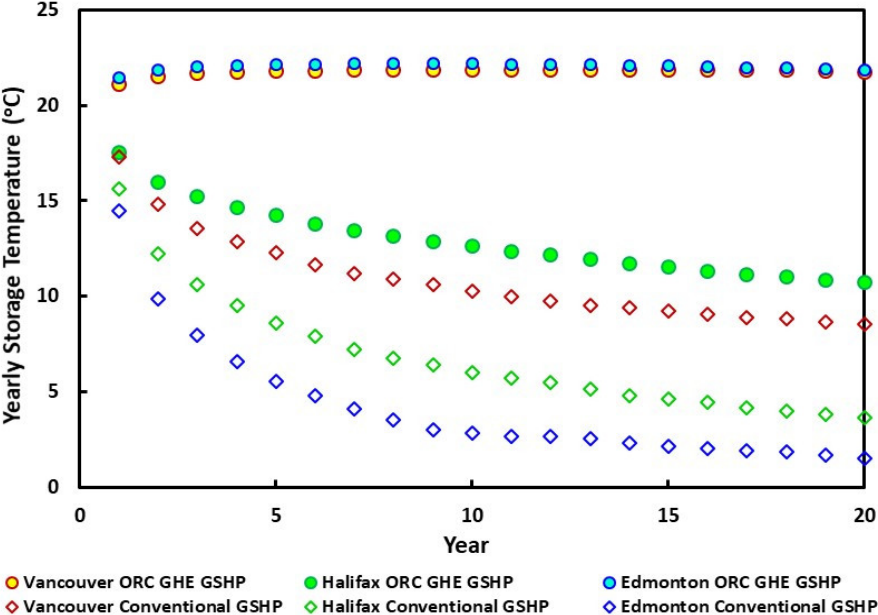
Figure 8. GHE average storage temperatures during 20-year period for each system and city.